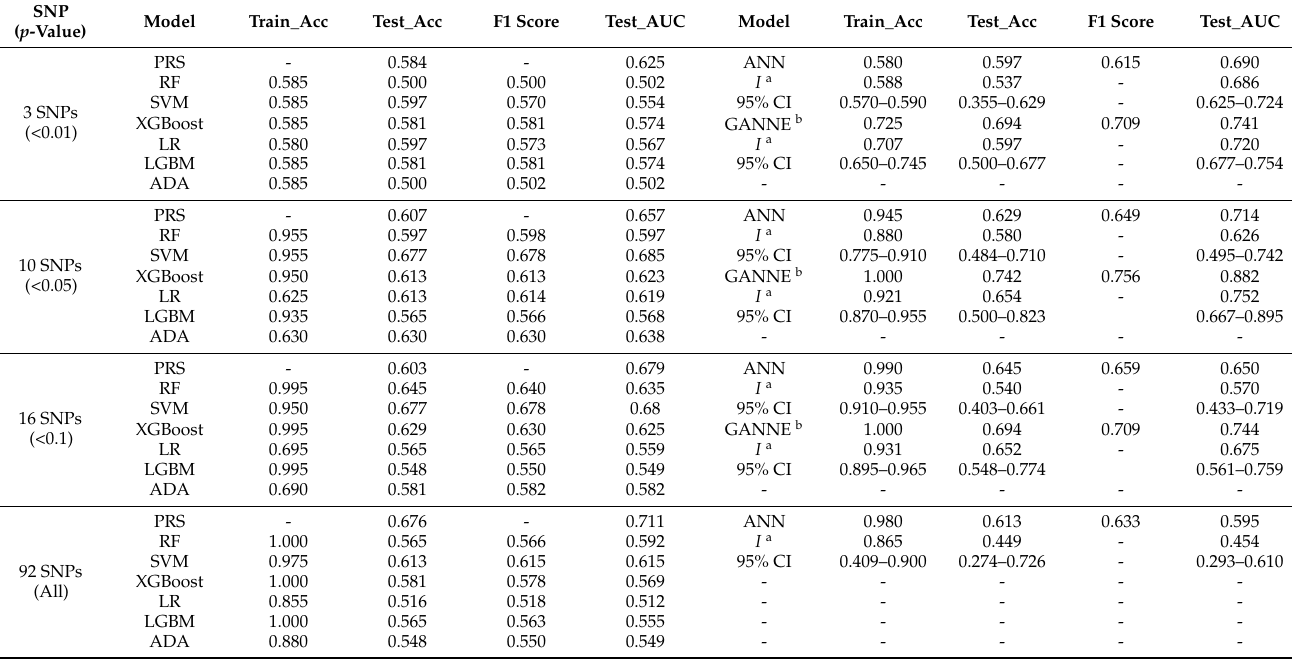
Table 2. Comparison of model performance by using nine risk prediction methods and four sets of